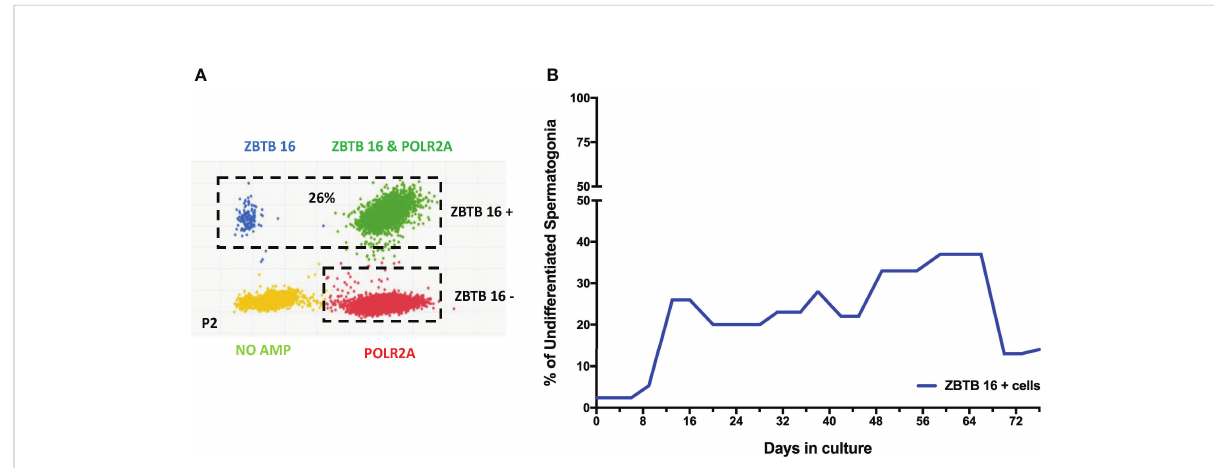
FIGURE 5 Digital PCR analysis was used to assess the population of undifferentiated spermatogonia expressing ZBTB16 (PLZF) marker and housekeeping gene POLR2A in testicular cells in culture: After 2nd passage from 15-year-old KS patient (A) . The same analysis was repeated at different time points. The graph shows the average undifferentiated spermatogonia population during the culture of testicular cells from KS patients (B)